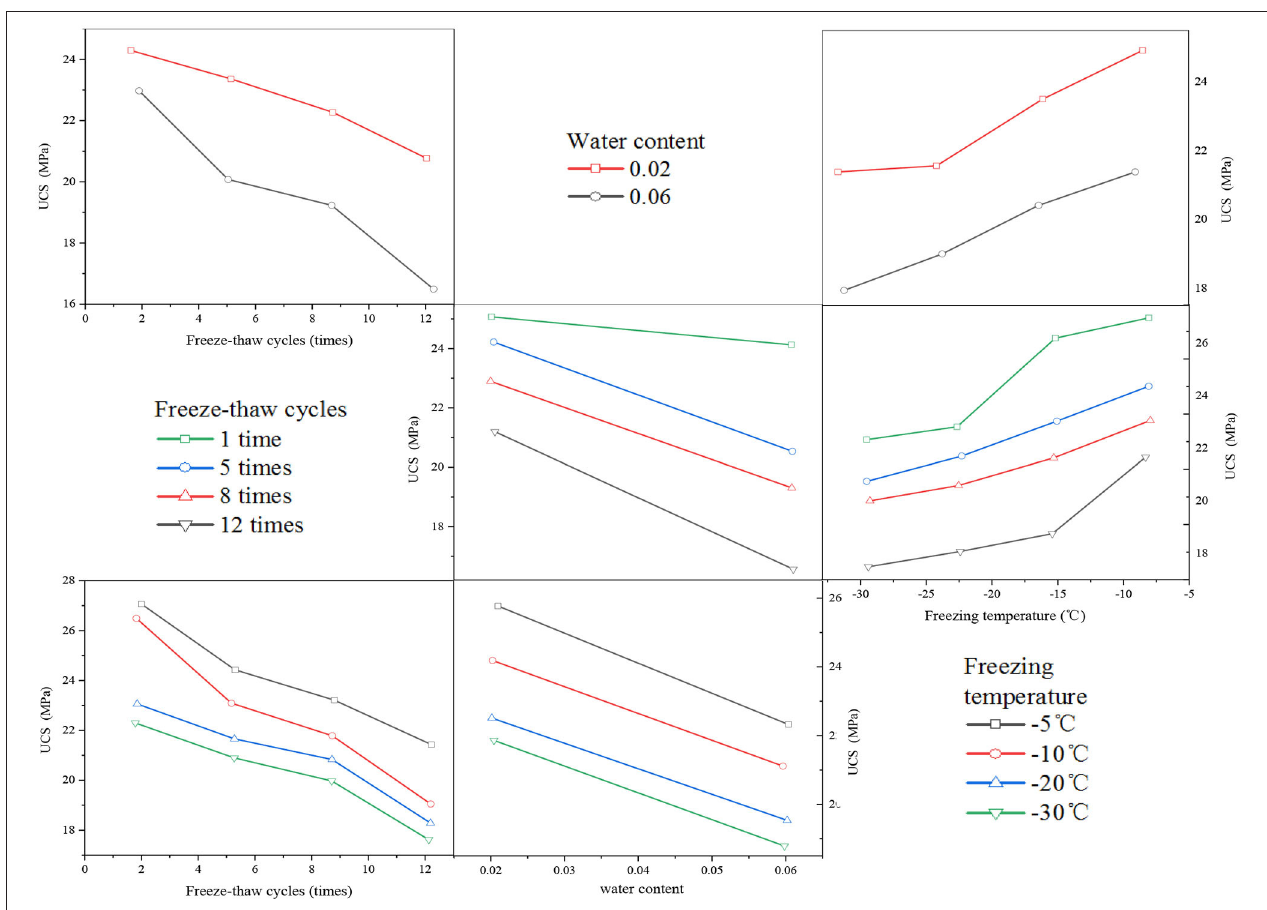
FIGURE 6 | Pareto diagram of standardization effect.